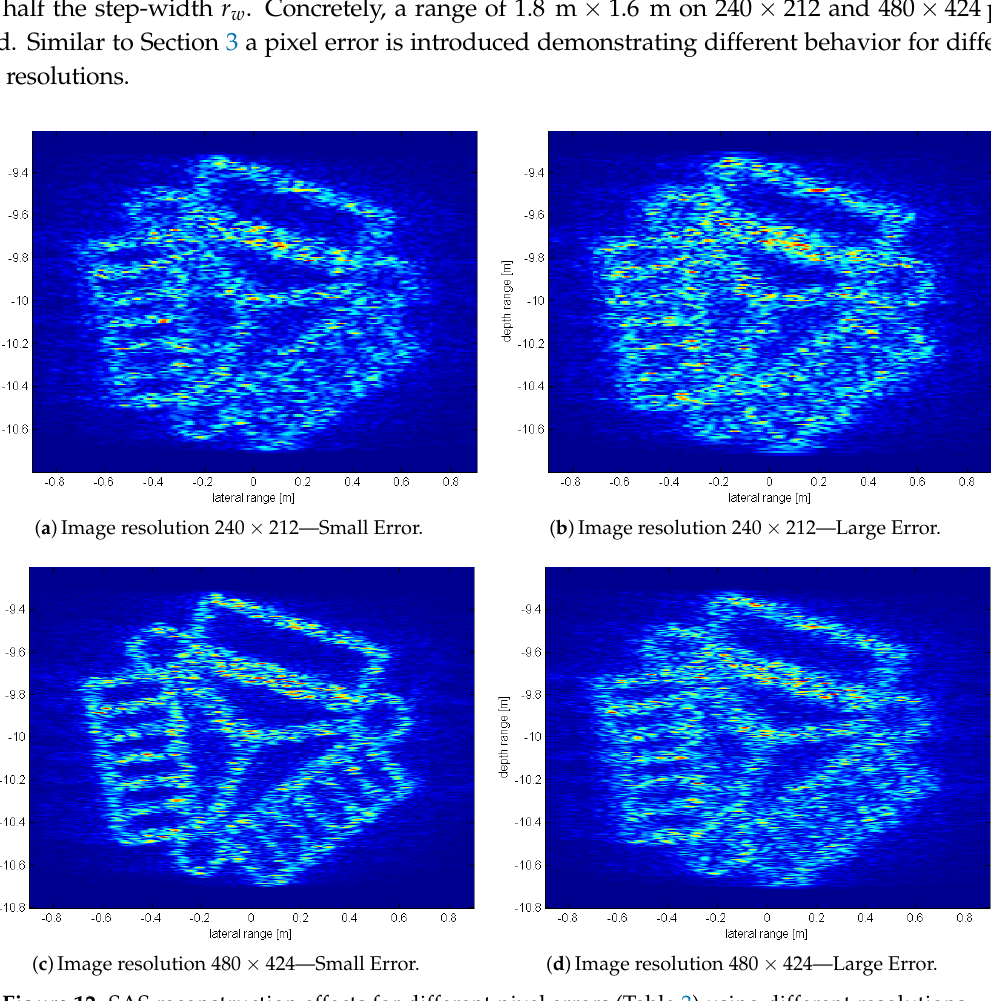
Figure 12. SAS reconstruction effects for different pixel errors (Table 3) using different